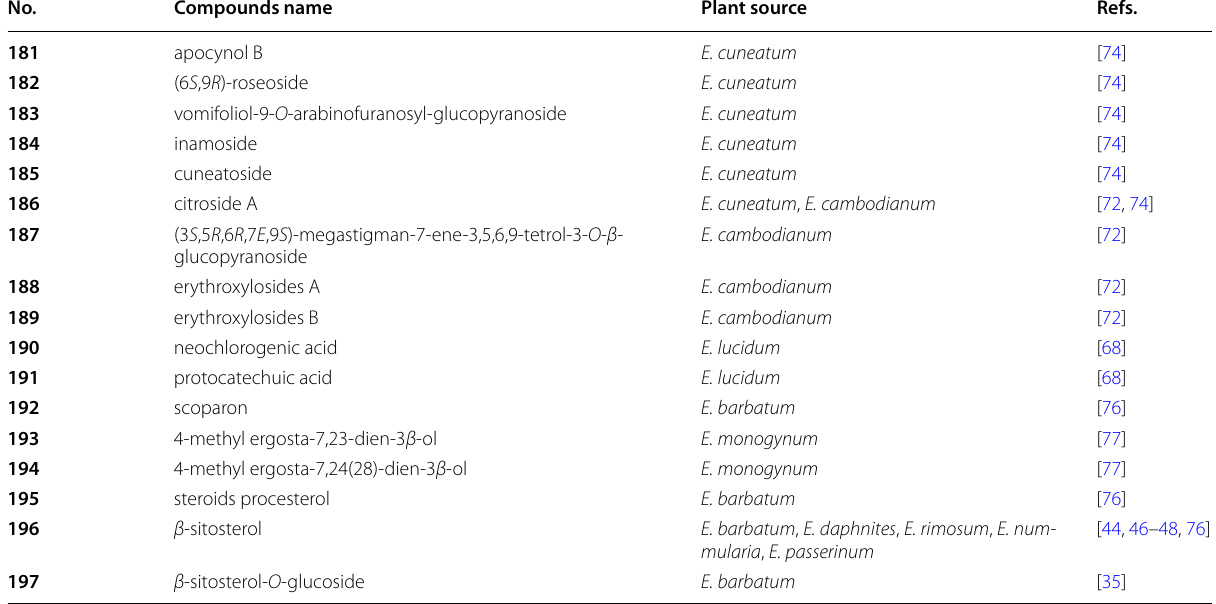
Table 8 Other constituents isolated from Erythroxylum plants No.